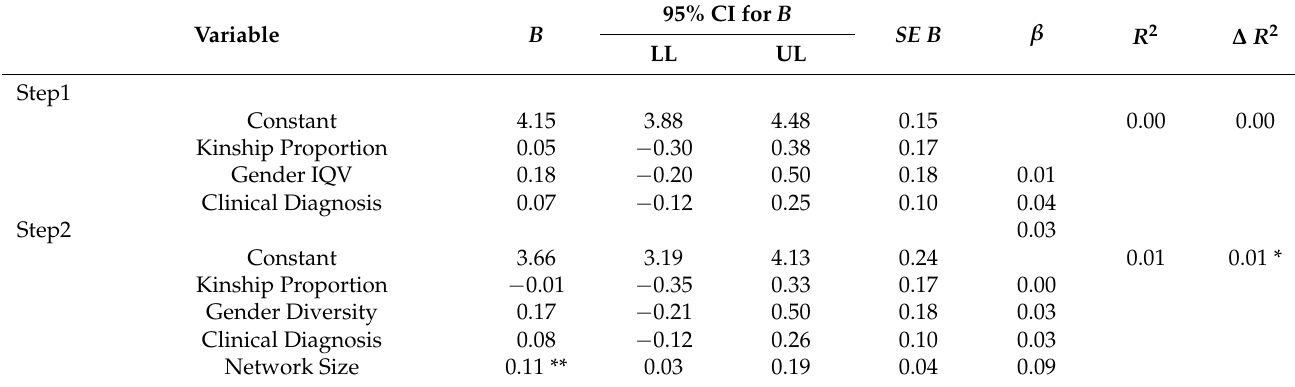
Table 4. Hierarchical linear regression results for depression mitigation behaviors: evaluating the role of network size.